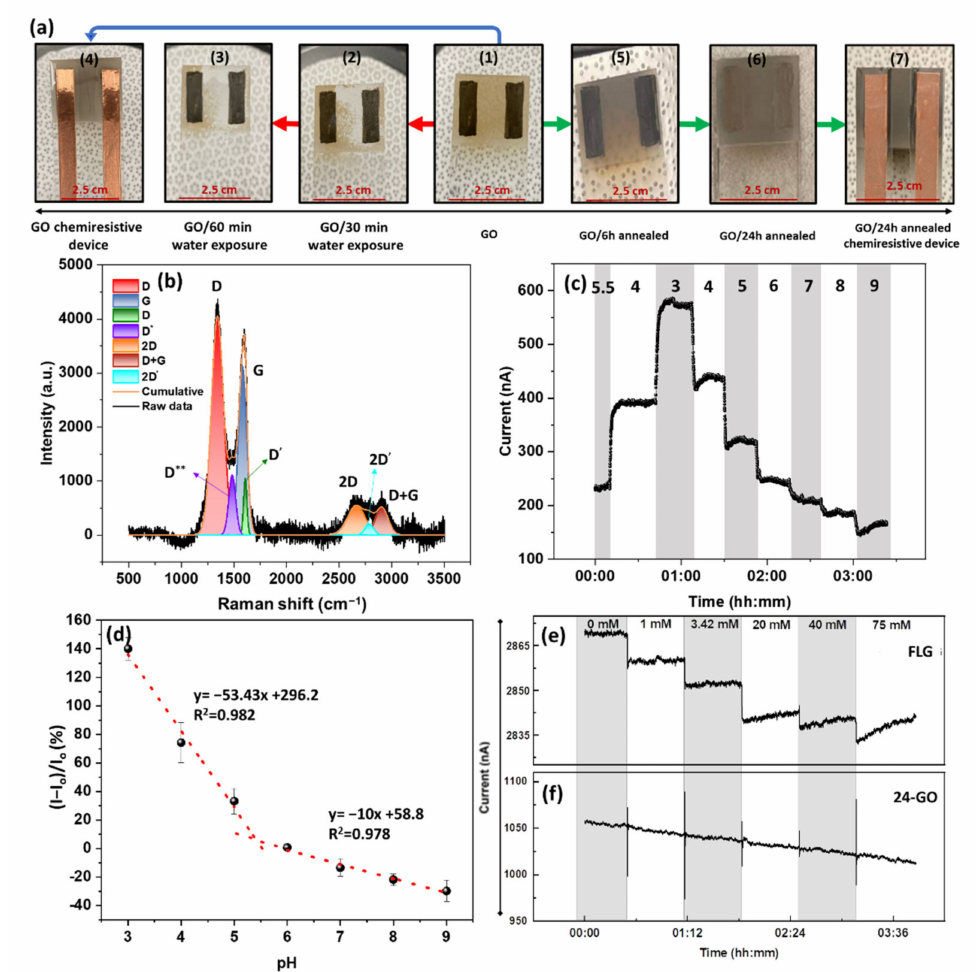
Figure 7. ( a ) The GO sensor fabrication: ( 1 ) Bare GO; ( 2 ) Bare GO exposed to the aqueous solution for 30 min; ( 3 ) Bare GO exposed to the aqueous solution for 6 min; ( 4 ) tTe GO chemiresistor without water exposure; ( 5 ) GO annealed for 6 h and ( 6 ) 26 h; ( 7 ) The 24 h annealed GO-based chemiresistor. ( b ) Deconvoluted Raman spectrum of 24 h-GO represents the presence of (from left to right): D, D*, G, D’, 2D, 2D’, D + G, and an I D /I G ratio of 1.3. ( c ) The pH response and ( d ) calibration curve of 24 h-GO (I o = 242 nA). The solution conductivity response of ( e ) FLG (I o = 2870 nA) and ( f ) 24 h-GO-based devices (I o = 1050